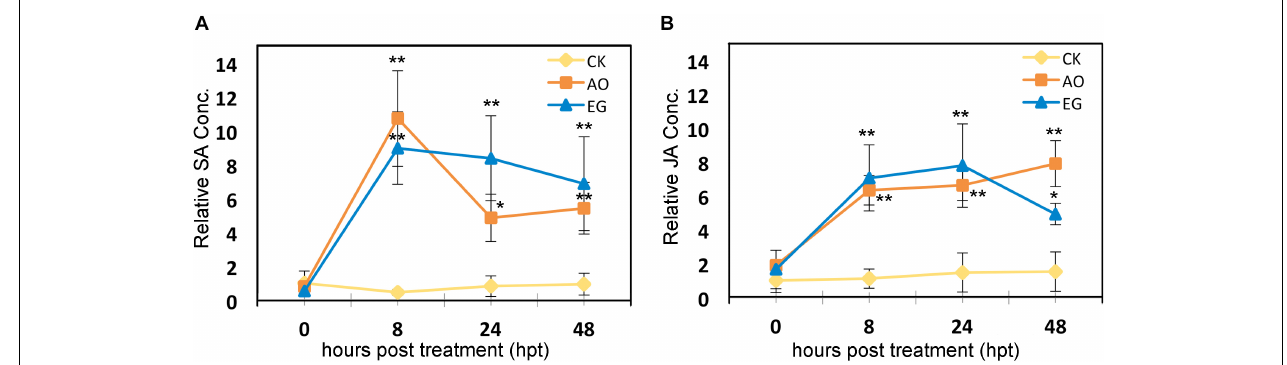
FIGURE 7 | Effects of anise oil and eugenol on the endogenous SA and JA contents. Fourteen-day-old tomato seedlings were treated with a control solution (CK), eugenol (EG), or anise oil (AO). The treated leaves were harvested just before the treatments (0 h) and at 8, 24, and 48 h after treatments. The endogenous SA (A) and JA (B) contents were detected. The SA and JA levels of the untreated tomato plants was treated as the normalized reference, with a value of one. Bars represent the mean ( ± standard deviation) from two measurements (each with triplicate samples). Significant differences between control and anise oil- or eugenol-treated plants were assessed with Student’s t -test ( ∗ P < 0.05; ∗∗ P <